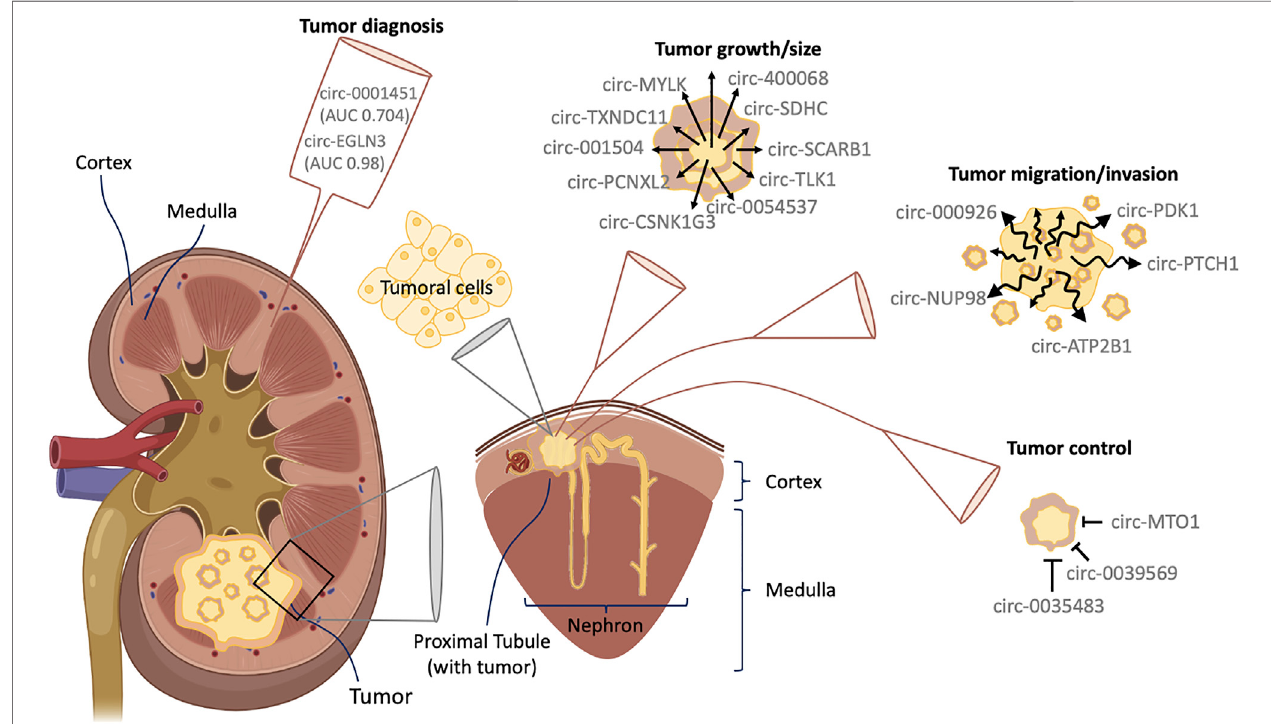
FIGURE 1 | Interaction between circRNAs and RCC. RCC comes from epithelial cells in the proximal tubule, located in the renal cortex of the nephron. The fi gure shows some interactions described in the main text between circRNAs and RCC as well as those proposed as good candidates for RCC diagnosis.